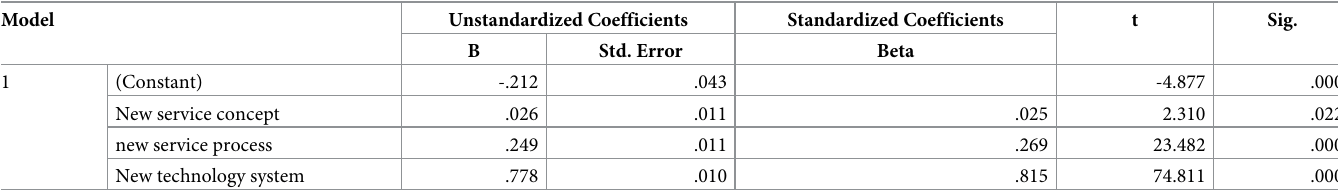
Table 6. Hierarchical result of service innovation and customer